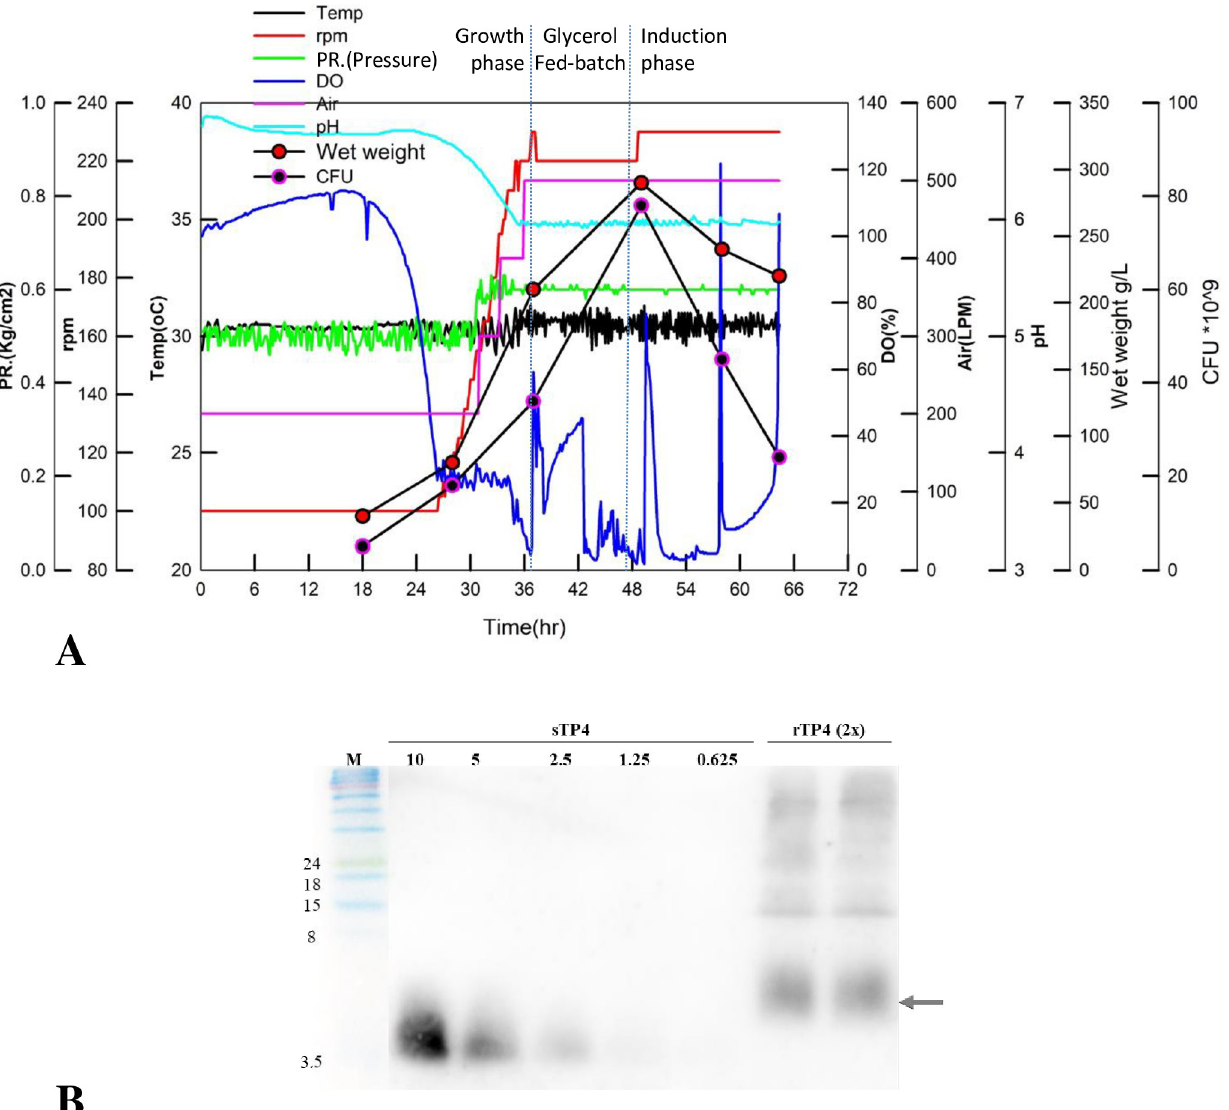
Fig 1. Scale-up expression of rTP4 in P . pastoris in a 500-liter fermenter. (A) The dissolved oxygen (%), pH, RPM and temperature (˚C) of broth during incubation of a P . pastoris X-33 transformant in BSM. (B) Western blot analysis profiles of recombinant rTP4 expression. M: Molecular weight marker; sTP4: Synthetic TP4 with concentrations of 10, 5, 2.5, 1.25 and 0.635 ng/ μ L; rTP4: Recombinant TP4.